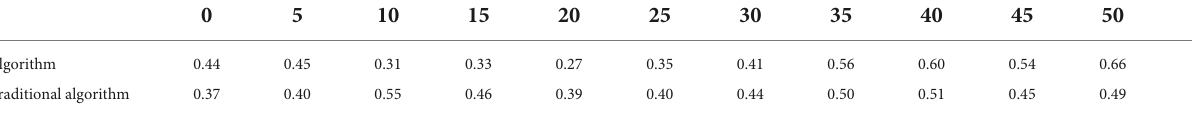
TABLE 1 Influence of different number of partition intervals on results.